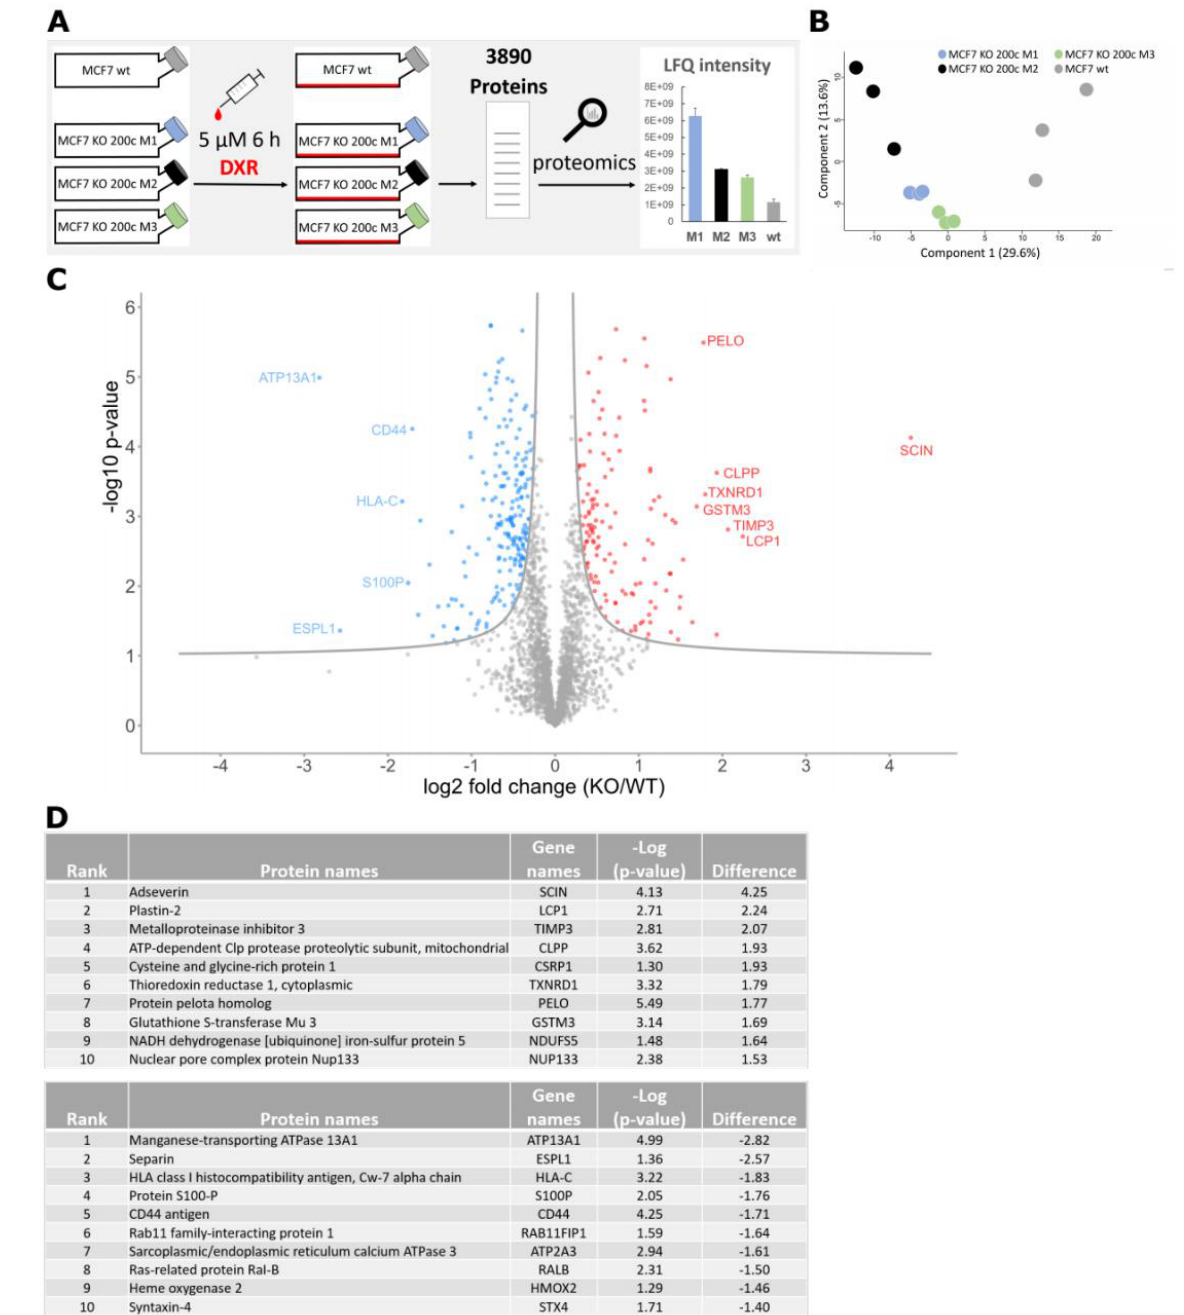
Figure 1. A proteomic analysis revealed novel hsa-miR-200c targets and altered signaling pathways in the field of detoxification from chemotherapy. ( A ) Experimental design of the proteomic approach of three monoclonal hsa-miR-200c knockout (KO) cell lines (M1: blue, M2: black and M3: green) vs. the parental MCF7 wt cells (gray) upon 6 h of 5 µM doxorubicin (DXR) treatment ( n = 3). ( B ) Principal component analysis (PCA) of the hsa-miR-200c KO clones and MCF7 wt proteome profiles. Numbers in parentheses indicate the percentage of variation each component explains. ( C ) Volcano plot showing regulated proteins upon doxorubicin treatment in hsa-miR-200c positive MCF7 breast cancer cells vs. hsa-miR-200c KO cells. Significantly regulated proteins are indicated in red (upregulated) or blue (downregulated). ( D ) Top 10 list of proteins being significantly upregulated (upper table) or downregulated (bottom table) in DXR-treated MCF7 KO 200c cells compared to DXR-treated MCF7 wt. All genes are ranked for the biggest difference to MCF7 wt